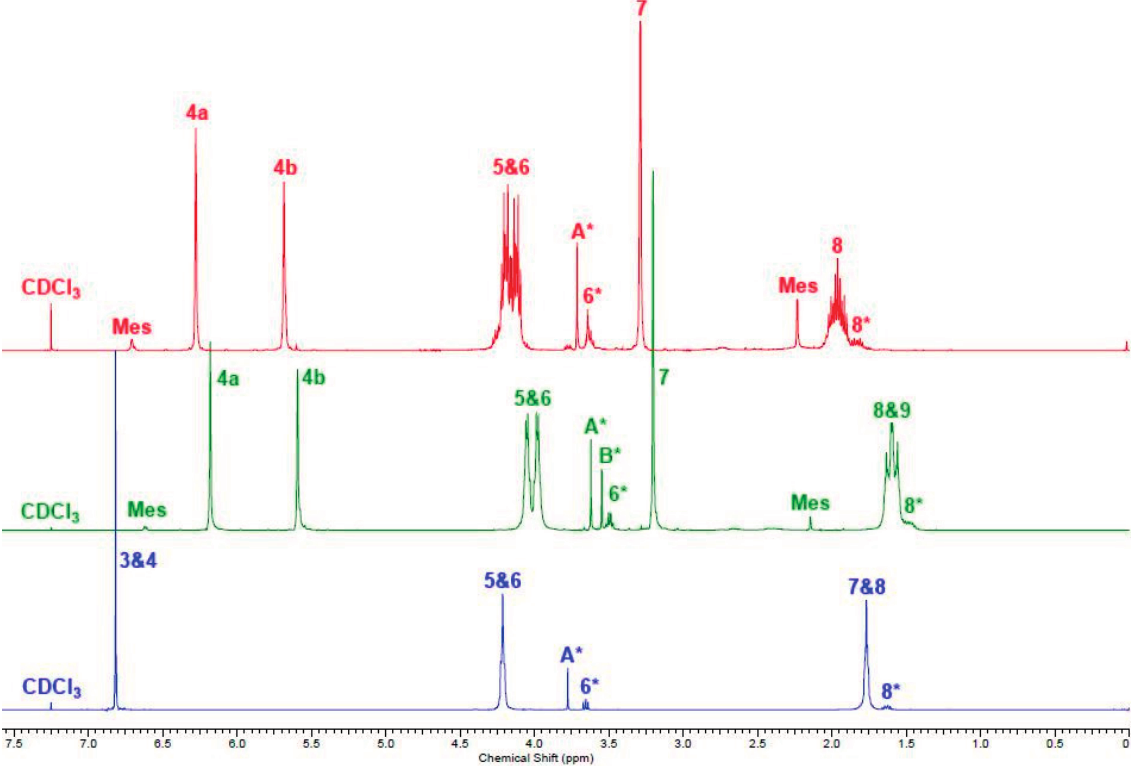
Figure 1. 1 H NMR spectra of PPI (red); PBI (green); PBFu (blue). The numbered